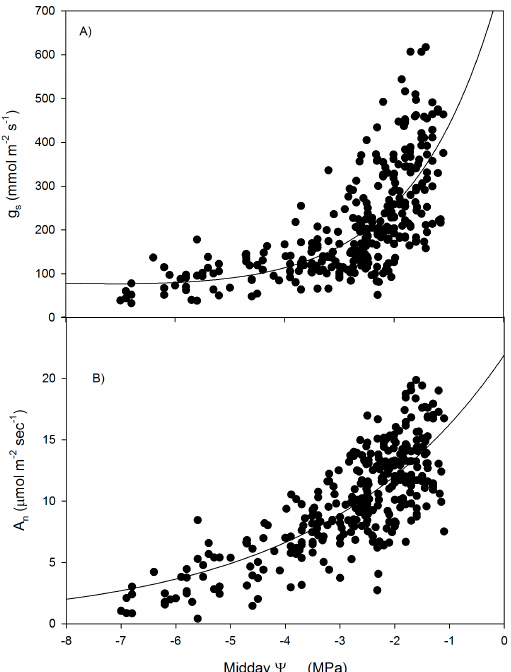
Figure 1. Relationship between ( A ) stomatal conductance (g s , mmol m − 2 s − 1 ) and ( B ) net photosynthesis (A n , μ mol m − 2 s − 1 ) relative to the stem water potential ( Ψ SWP , MPa) measured at midday. The best fit relationship for the entire g s data pool was performed using a double exponential function: y = 39 × e ( − 0.08 x ) + 744 × e (0.63 x ) ; r 2 = 0.51: p < 0.0001; the best fit relationship for the entire A n data pool was performed using a double exponential function: y = 3.1 × e (0.29 x ) + 18.9 × e (0.30 x ) ; r 2 = 0.61, p < 0.0001.